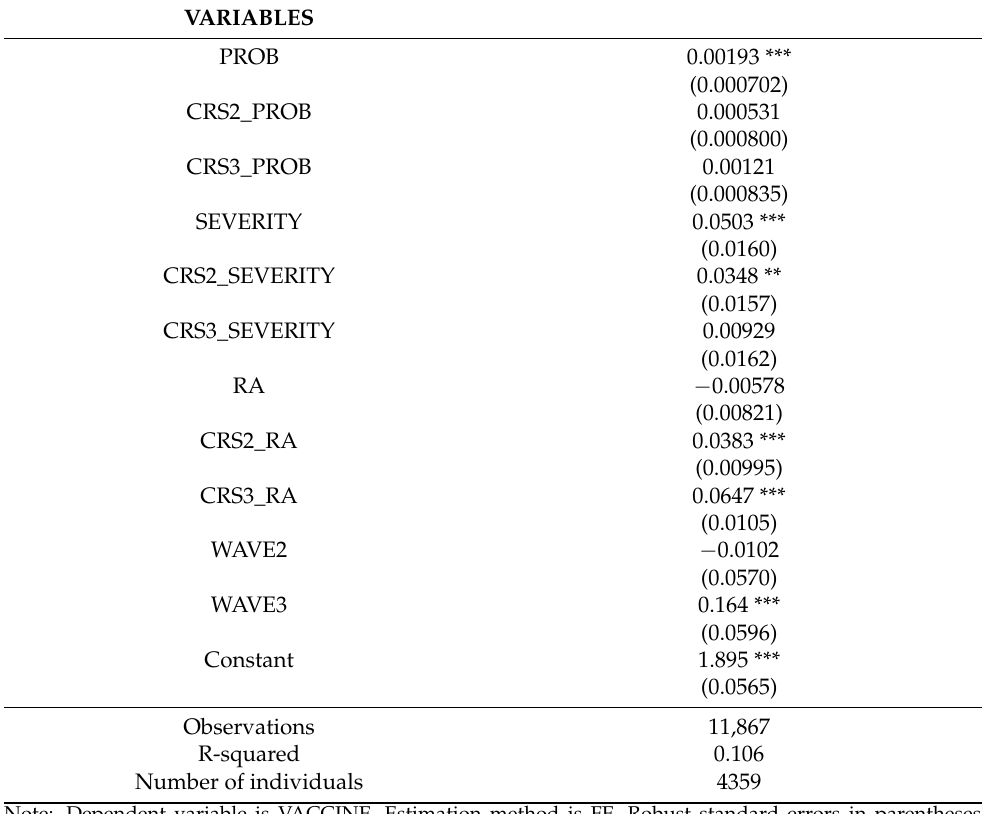
Table 6. Estimation results of Equation (1) incorporating cross